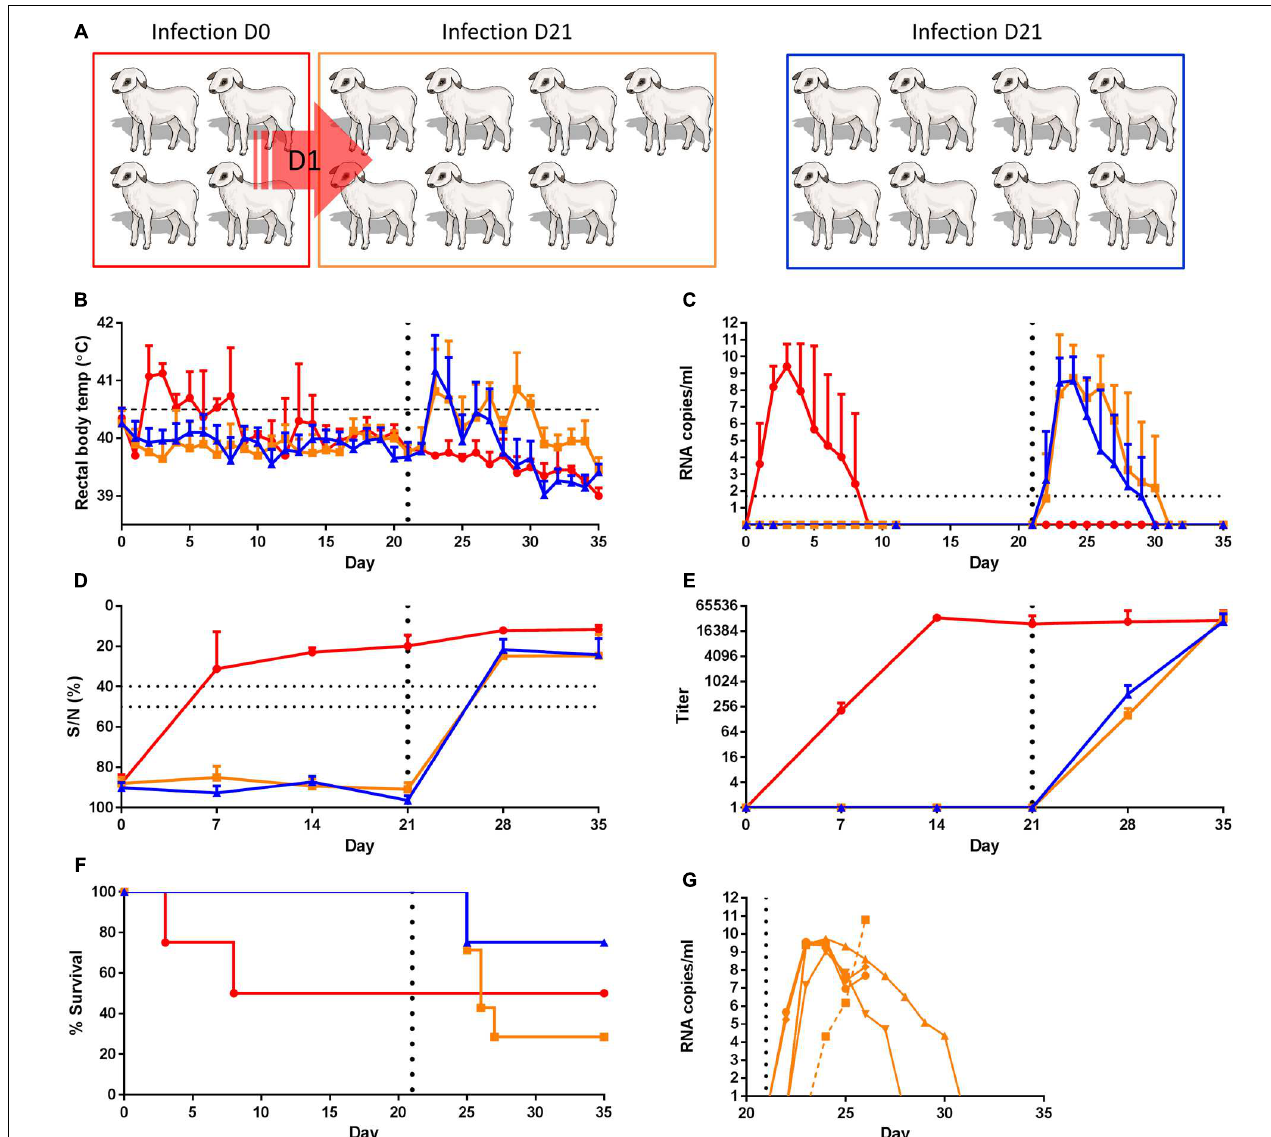
FIGURE 2 | Contact-exposure with viremic lambs does not affect the susceptibility to infection of healthy contact lambs. (A) Cartoon representing the experimental design. Four lambs (red) were inoculated on day 0 (D0) with RVFV via intravenous route and co-housed with eight untreated lambs (orange) the next day. One lamb died from unrelated illness and was removed from the study. A group of eight lambs functioned as a control group (blue). On D21 contact-exposed lambs (orange) and control lambs (blue) were experimentally infected. Rectal temperatures (B) , viremia (C) , antibody responses by ELISA (D) and VNT (E) and % survival (F) are depicted. Error bars represent averages with SD. (G) displays viral RNA copies of each individual lamb of the orange group as determined from day 20, of which the average viral RNA levels are displayed in (C) . Measurements of samples of lamb 8836 are connected by a dashed